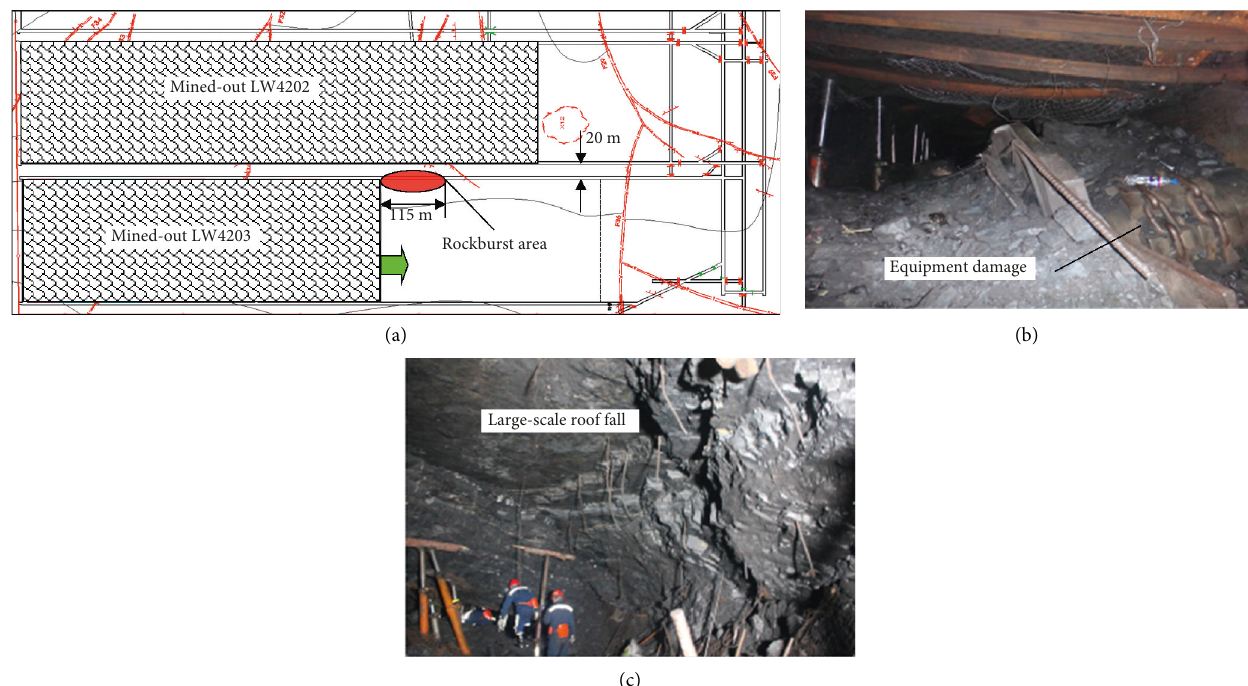
Figure 1: Rockburst photos of gob-side entry in Danshuigou Coal Mine: (a) plane position map of working face; (b) field photo of equipment damage; (c) field photo of roof